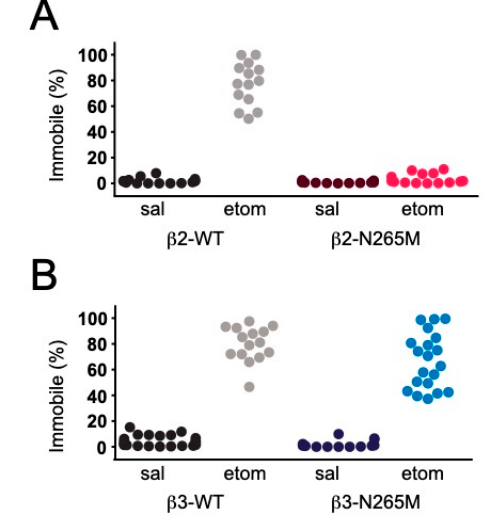
Figure 2. Sedative effect of etomidate. ( A ) Etomidate produced strong sedation (a high level of immobility) in β 2-WT mice [95% C.I., 63.6, 87.9] but had little effect in β 2-N265M mice [ − 0.315, 6.44].